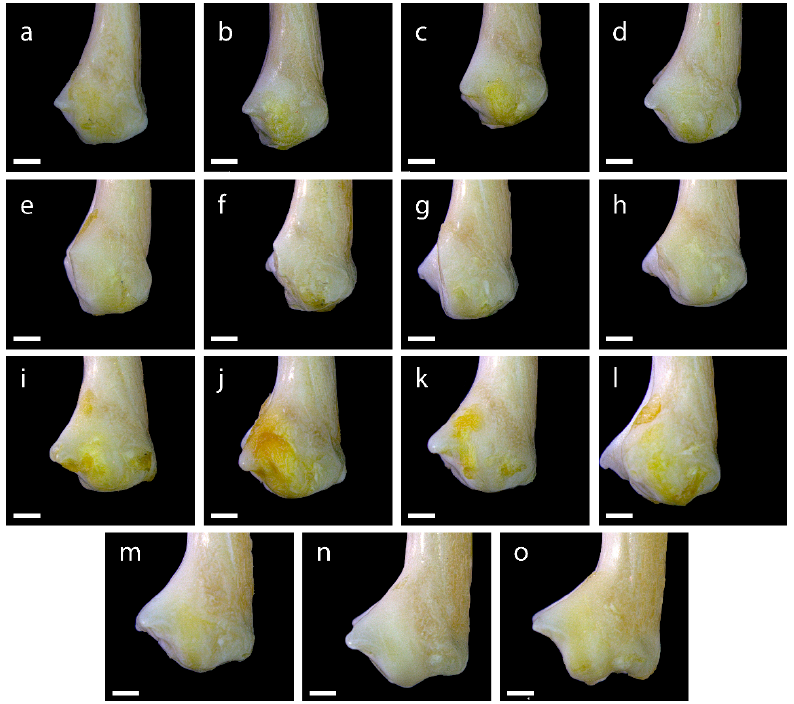
Figure A20. Microscopic images of the lateral right view of the pinnules of P. bichir PO6. The images ( a – o ) correspond to the 1st, 2nd, 3rd, 4th, 5th, 6th, 7th, 8th, 9th, 10th, 11th, 12th, 13th, 14th, and 15th pinnules, respectively. Scale = 1 mm.